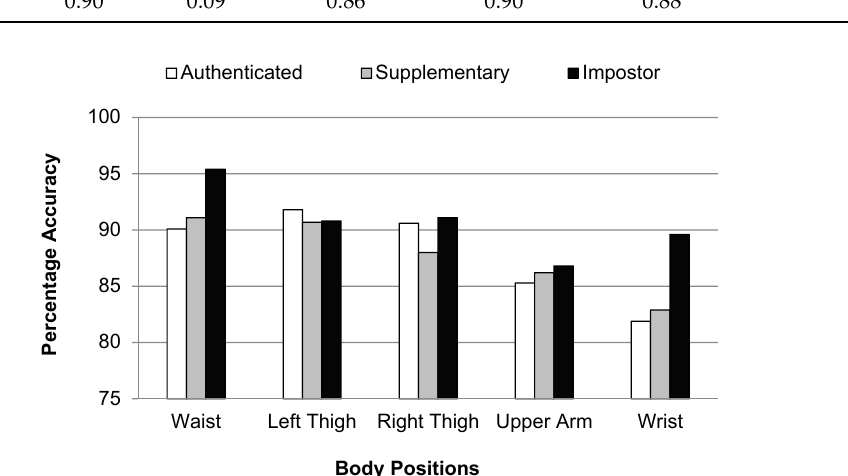
Figure 9. Individual classification accuracies of different user classes at five different body positions.